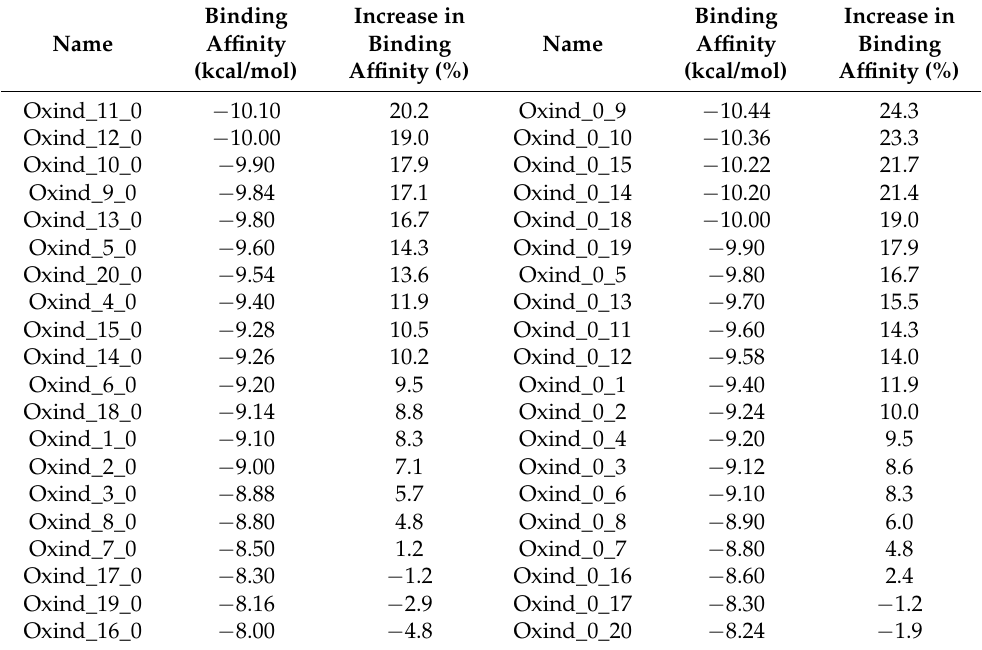
Table 1. The values of binding affinity of oxindole monoderivatives towards GSK-3 β . Increase